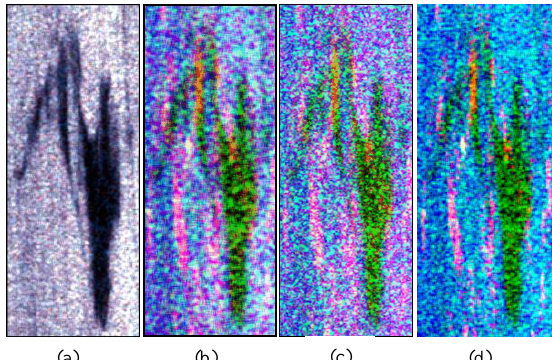
Figure 5: images of mean of (a) Magnitude and power measures of HH and VV polarizations and (b) Pauli decomposition. (c) Krogager decomposition. (d) Freeman decomposition in window sizes of 5×5, 7×7,